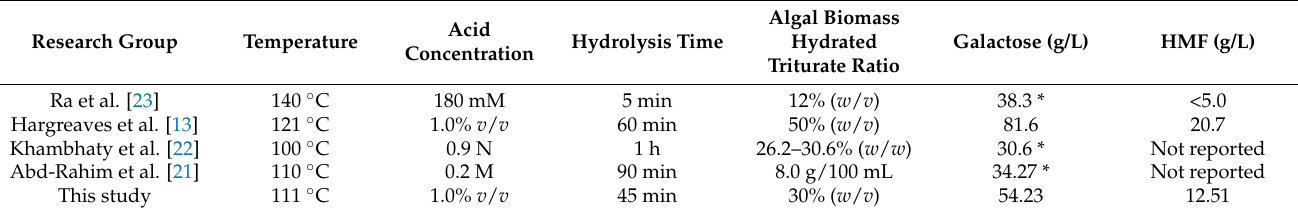
Table 6. Acid pretreatment conditions reported in literature for K. alvarezii